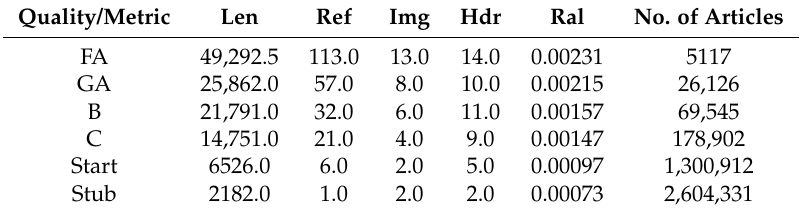
Figure 1. Distribution of metrics in articles of each quality class in English Wikipedia (featured article (FA)—the highest grade; stub—the lowest). Source: own calculation. Table 1. Median of metrics in each quality class in English Wikipedia. Source: own